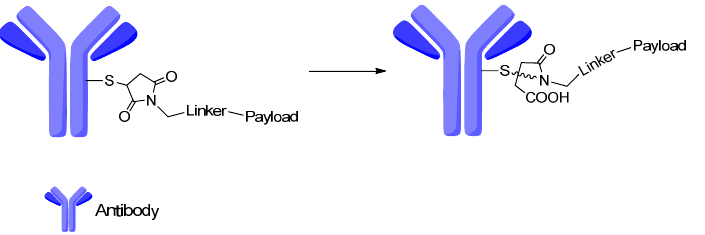
Figure 16. The hydrolysis of the succinimide-thioether ring results in a “ring-opened” linker. Adapted from reference [95].